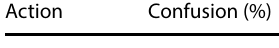
Table 2 Class oriented confusion on MSRAction3D dataset